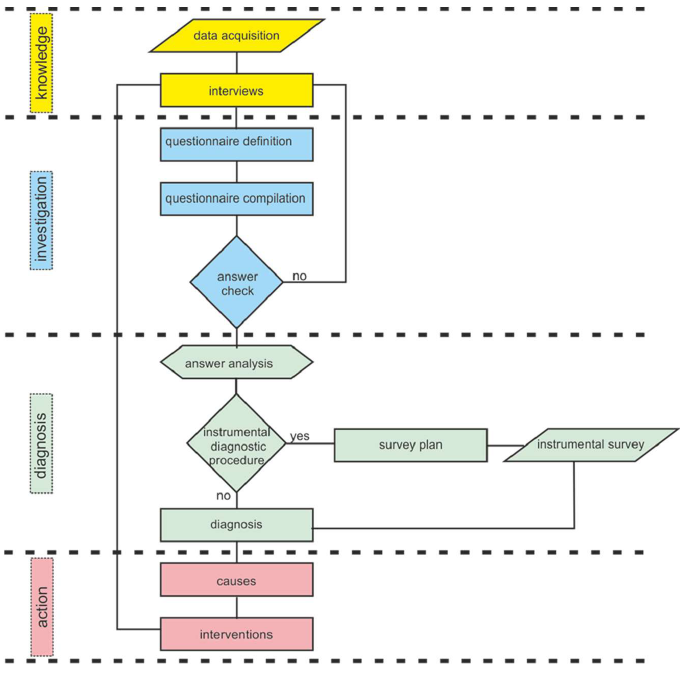
Figure 1. Flow chart of the proposed assessment method.